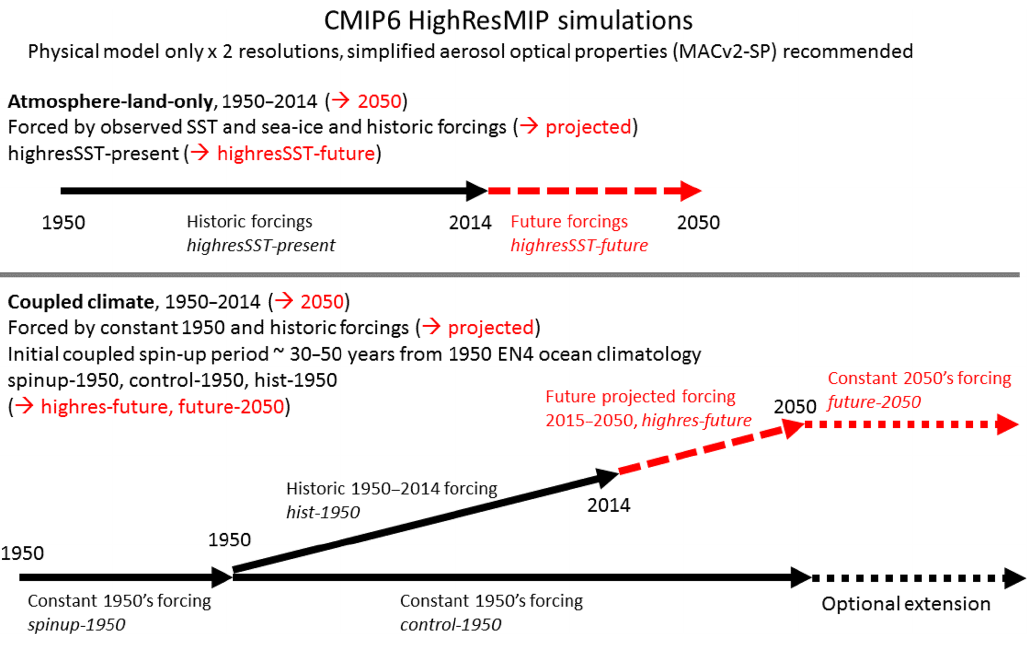
Figure 1. The HighResMIP experimental design, including the names of the component experiments and an indication of their relationship. Table 3. For each model resolution for the control-1950 simulation: the nominal CMIP6 resolution, the initial condition, total simulated years and costs of various model resolutions on a Cray XC40 with 36 cores per node, together with raw model output volumes. Model CMIP6 resolution Initial Total years Nodes Max turnaround Output